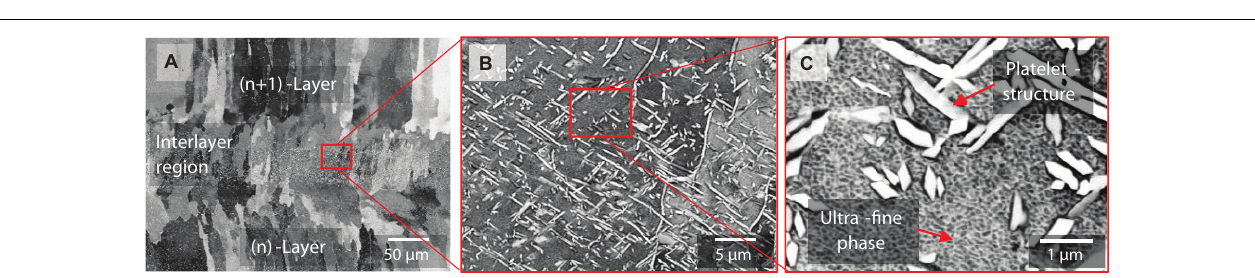
FIGURE 6 | SEM images of laser material deposition (LMD) fabricated A sample (as-built) microstructure at interlayer region in 5000- × (A) , 10000- × (B) , and 20000- × (C) magnification. Homogeneously distributed platelet-structures are visible in the interlayer region only. The matrix is composed of two ultra-fine phases, seen at high